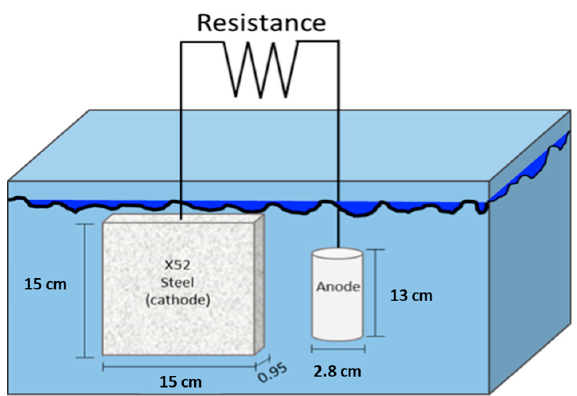
Figure 3. Experimental setup for the tests of cathodic protection. Measurement of voltage drop at both sides of resistance allowed us to calculate the electrical current flow at the circuit applying Ohm ʹ s Law. Seawater was kept in static con ‐ ditions and was not renewed throughout the experiment. Once the cell was assembled, the polarized potentials of the cathode, with respect to the saturated calomel electrode (SCE), located at a 1 cm approach to the steel sheet surface, in the function of the exposure time, were monitored. The cathode current density was also monitored with respect to time, calculated from the voltage drop across the resistance and the exposed area of the cathode. 3. Results and Discussion 3.1. Microstructure of Mg Anodes Figure 4 shows a characteristic powder diffraction pattern of pure Mg, as well as the sintered Mg ‐ 1Cr sample. The objective of the sintering was only to densify and no reaction was intended. As can be seen in Figure 4a (bottom), after the sintering, no secondary phases were detected. Besides, the amount of Cr or Nb used makes it difficult to detect, at least by X ‐ ray diffraction, if a tiny fraction reacted. Nevertheless, if we consider the phase diagrams of Mg ‐ Cr and Mg ‐ Nb [28,29] no secondary phase was expected. ( a ) ( b ) Figure 4. ( a ). Le Bail fits of the diffractogram of pure magnesium after thermal treatment. ( b ). Le Bail fits of the diffracto ‐ gram of Mg ‐ 1Cr after thermal treatment. 3.2. Electrochemical Tests.